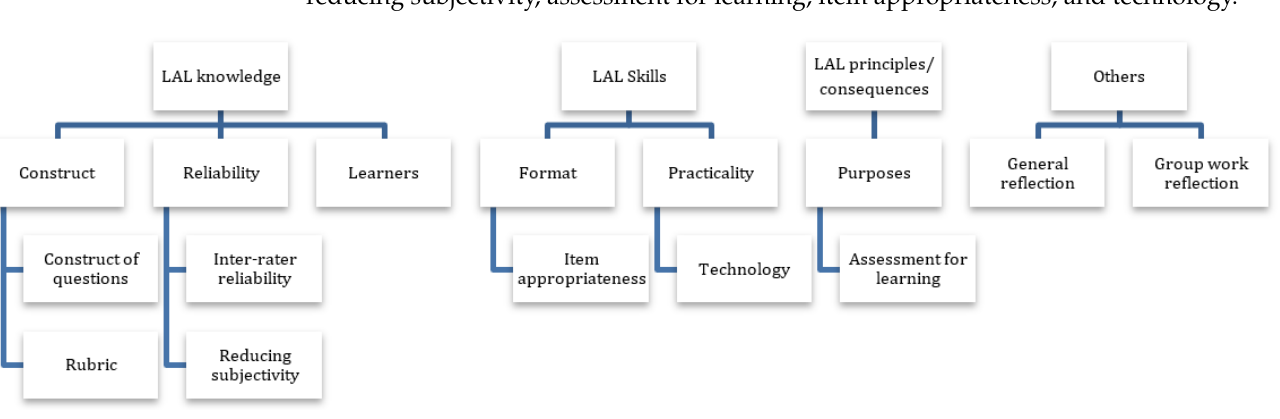
Figure 3. Planning stage. More precisely, through a series of Skype meetings with the inservice teacher that were arranged initially by the course instructor, the preservice teachers first conducted interviews with the inservice teacher. At the interviews, the inservice teacher shared her instructional strategies and materials with the preservice teachers. Based on the infor- mation collected in the interviews, the preservice teachers wrote reports on the test-takers, indicating their WIDA scores, first-language background, educational experience, curric- ulum, as well as the purpose of their assessment. Before the interviews were conducted, the course instructor and the inservice teacher spent substantial time setting up collaboration and preparing a few logistics. The logistics included selecting target ESOL student groups, setting up virtual interviews, implement- ing the assessment, and soliciting the inservice teacher’s and ESOL students’ feedback.